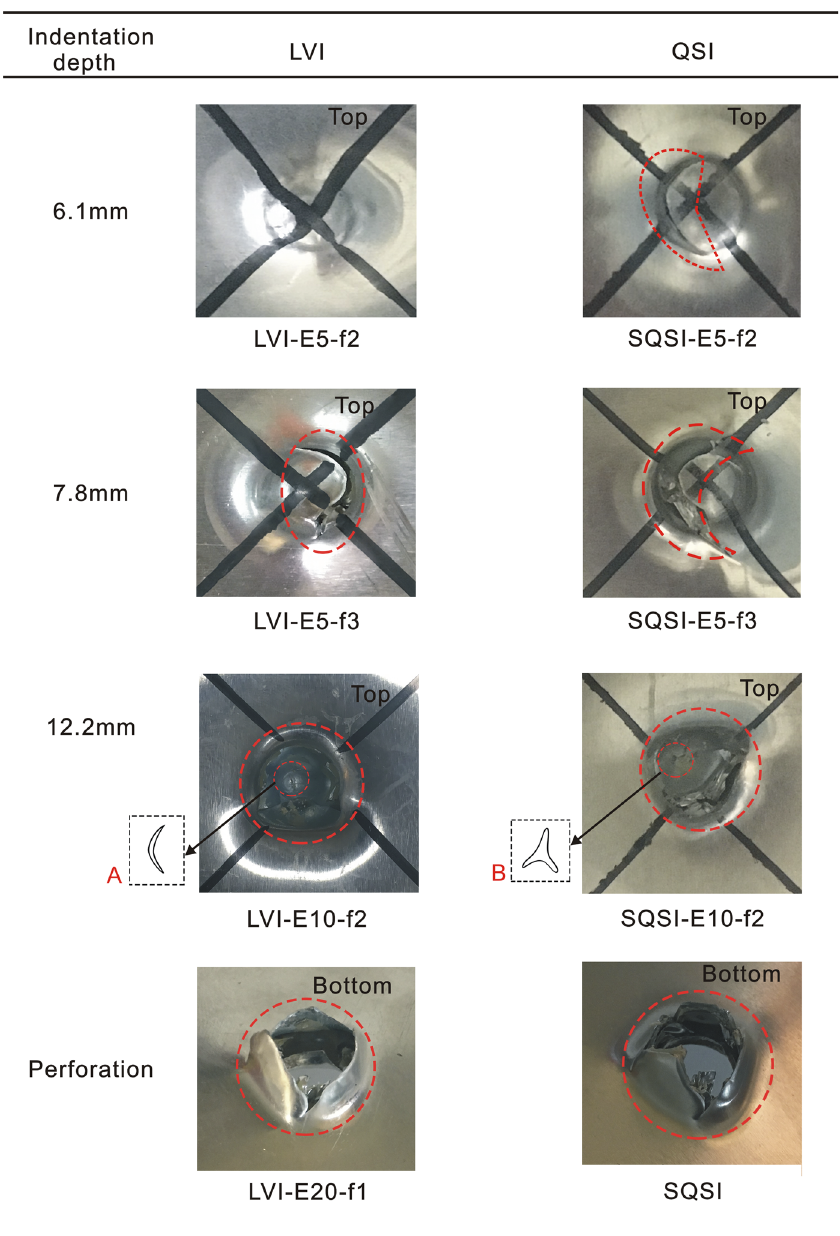
Figure 10: Comparison of damage after LVI and